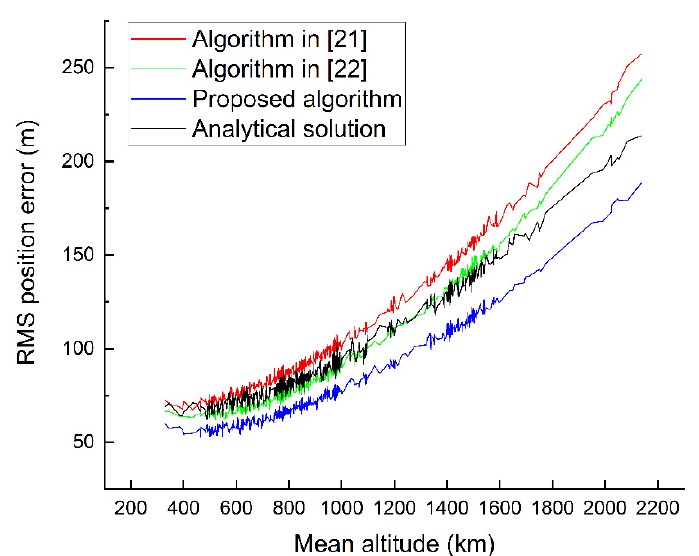
Figure 5. The RMS position errors for LEO space debris.